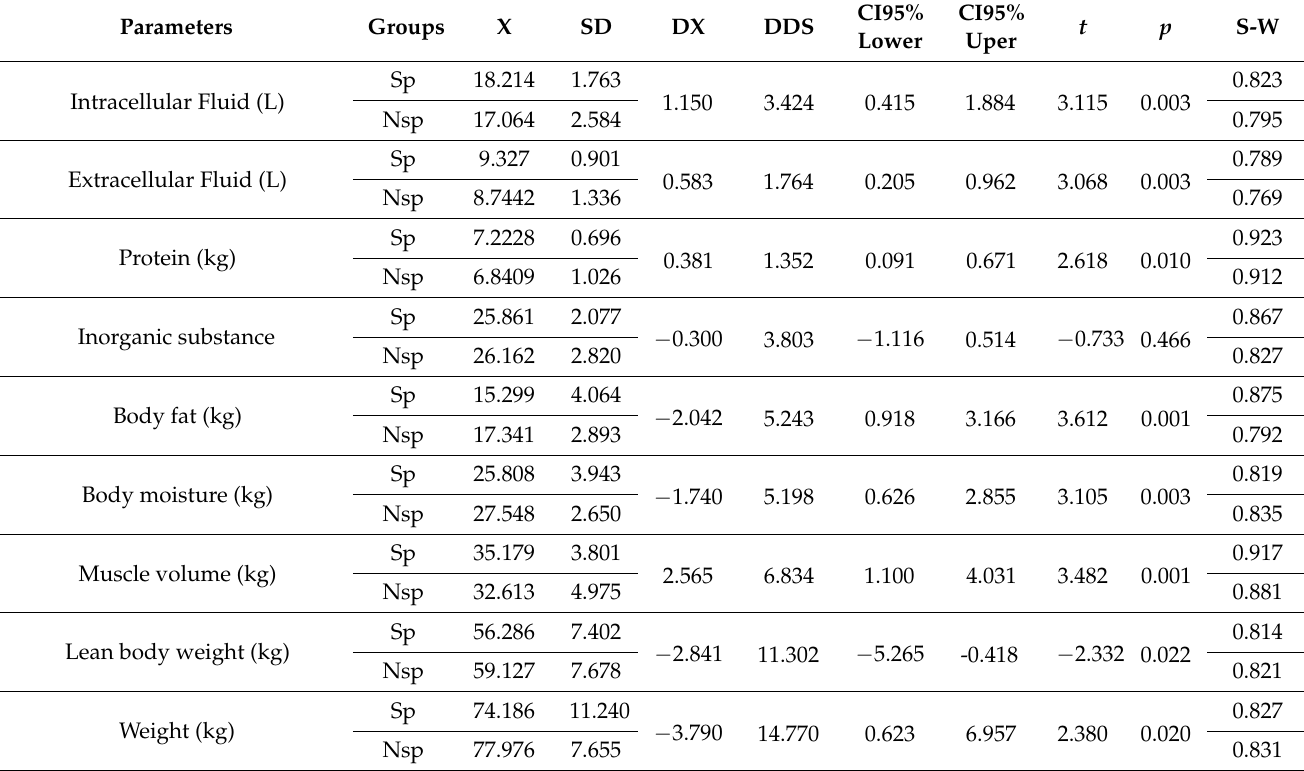
Table 4. Statistical analysis of the Nourishment for the male groups.